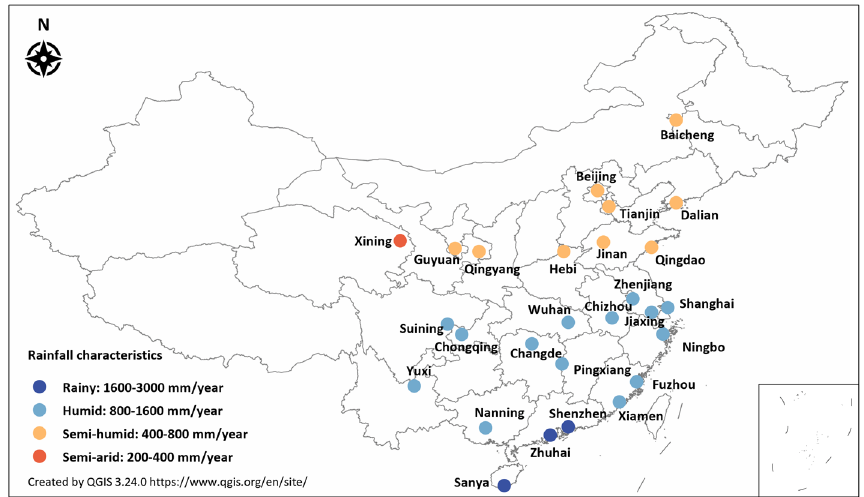
Figure 1. Distribution of SCP pilot cities and rainfall